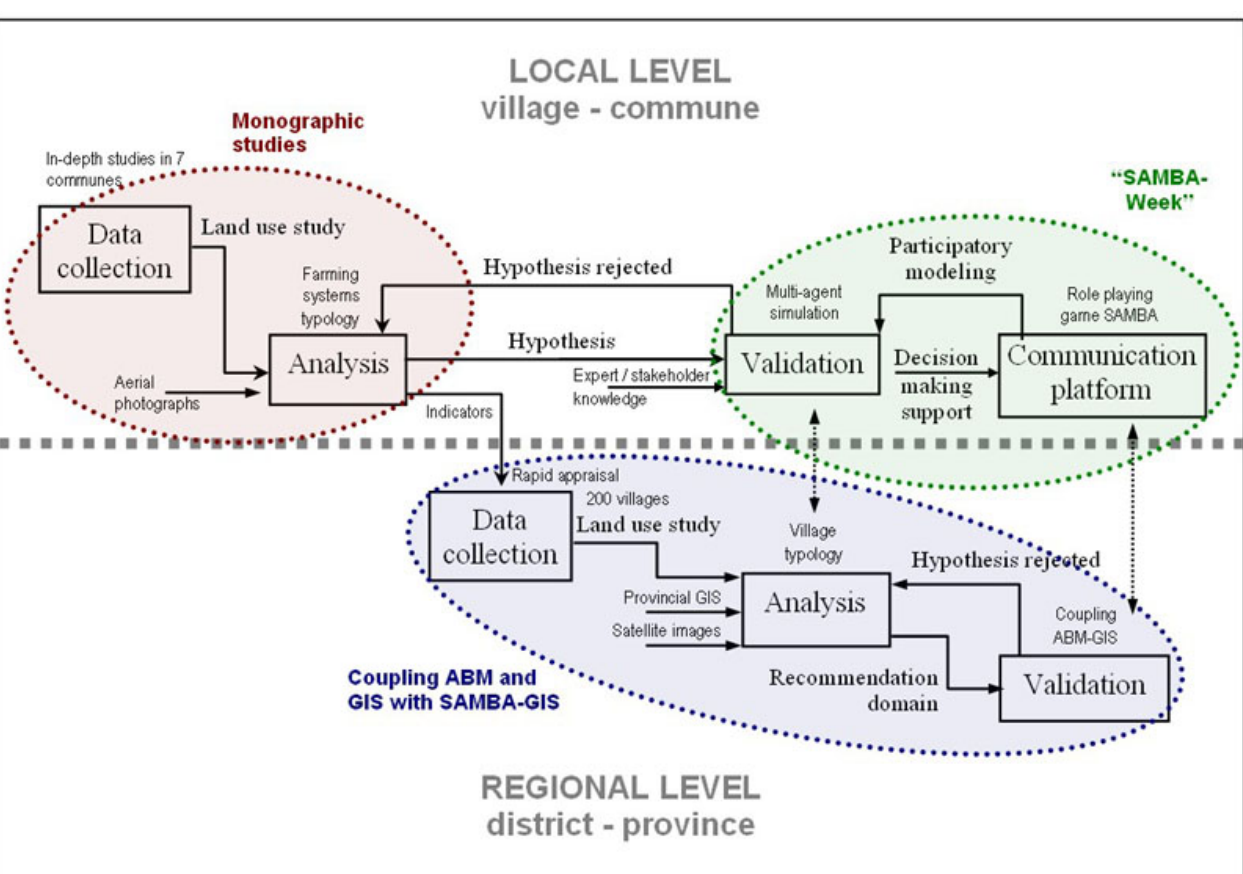
Fig. 10. Successive stages in the multiscale participatory simulation of land-use changes. ABM stands for agent-based